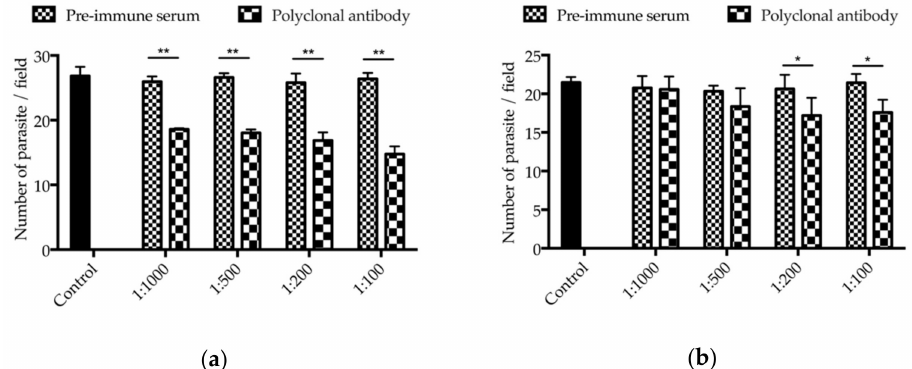
Figure5. Partial neutralizationof C. parvum invasion by antibodiesagainst INS-15. Hypochlorite-treated oocysts were pre-incubated with 1:1000, 1:500, 1:200, and 1:100 dilutions of antibodies against the INS-15 domain I ( a ), the INS-15-specific polypeptide antibodies ( b ), with pre-immune serum or